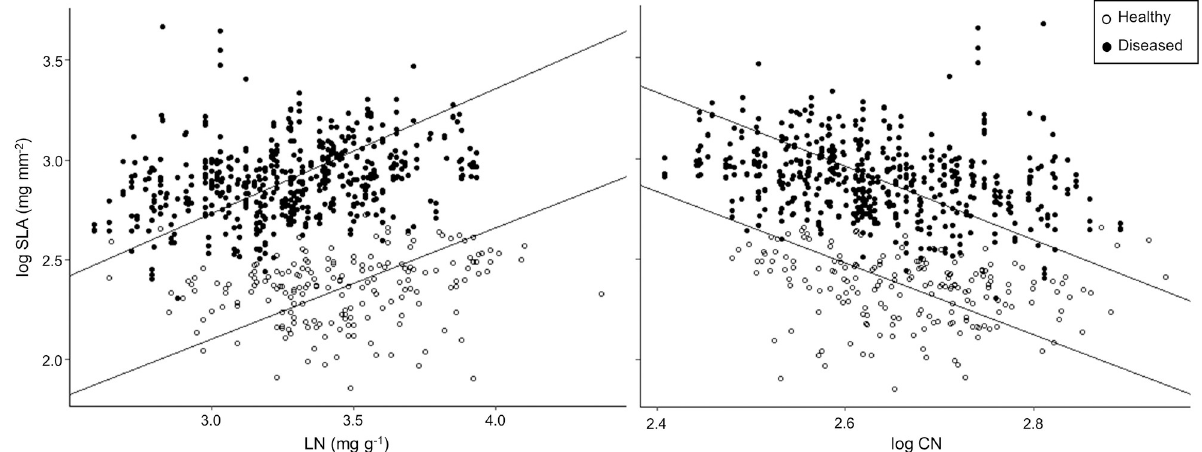
Fig 3. Key bivariate trait relationships from healthy and diseased leaves from the middle coffee plant stratum. (A) Log-transformed specific leaf area (SLA) and leaf nitrogen concentration (LN), and (B) log-transformed SLA and log-transformed leaf carbon to nitrogen ratio (CN), where n = 519 for diseased leaves and n = 192 for healthy